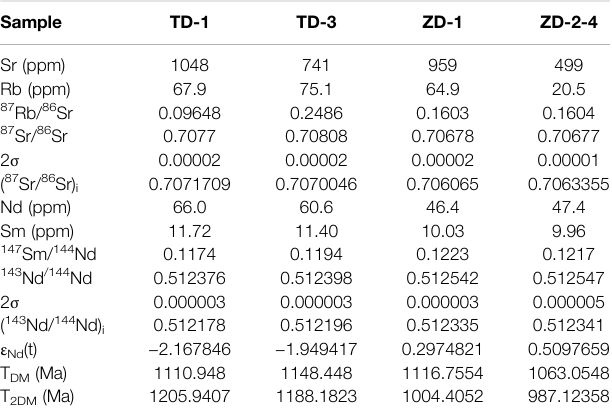
TABLE 4 | Whole-rock Sr and Nd isotopic compositions for the Longlin basalt